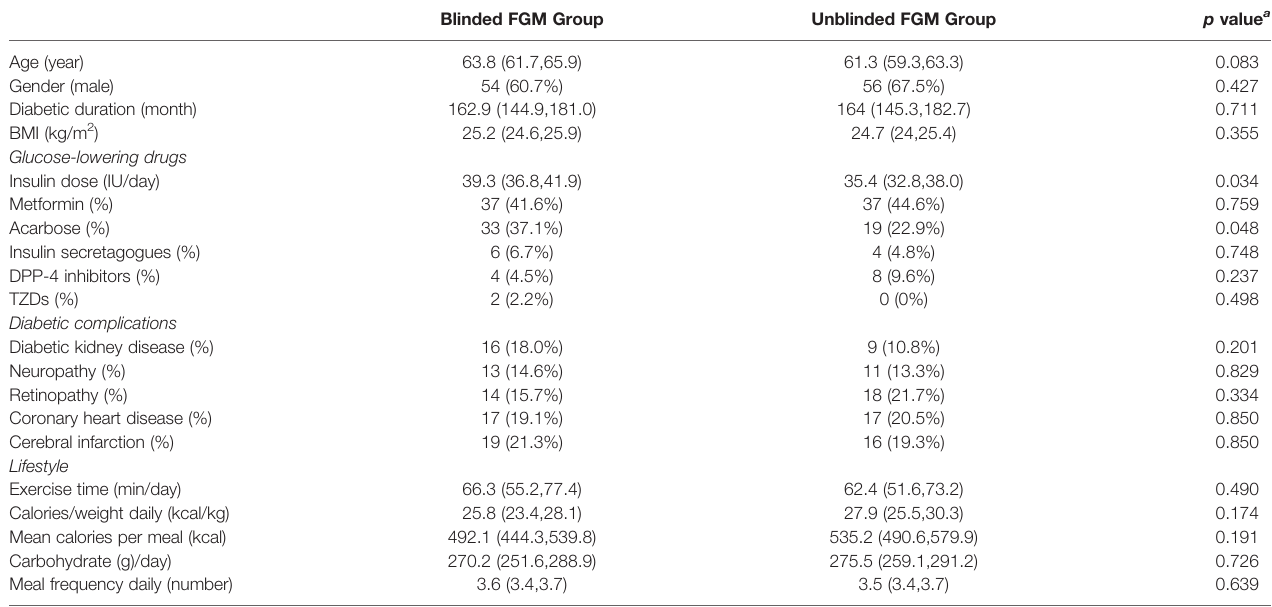
TABLE 1 | Baseline characteristics of